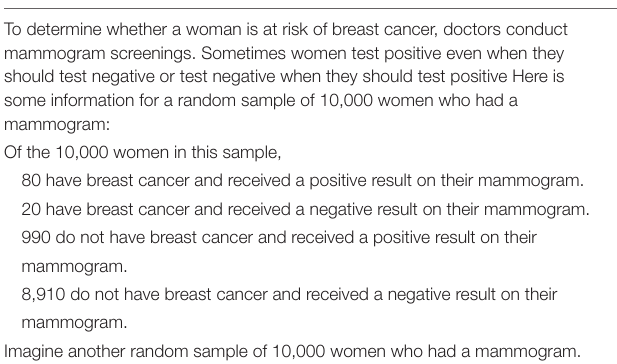
TABLE 6 | Example presentations with superordinate set organization for the mammography problem. Incongruent condition-Focus problem with superordinate set